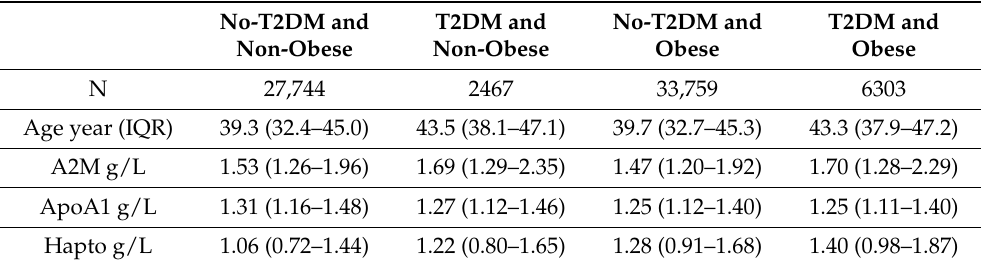
Table 4. Characteristics and median protein levels in men <50 years of age according to T2DM and obese status.